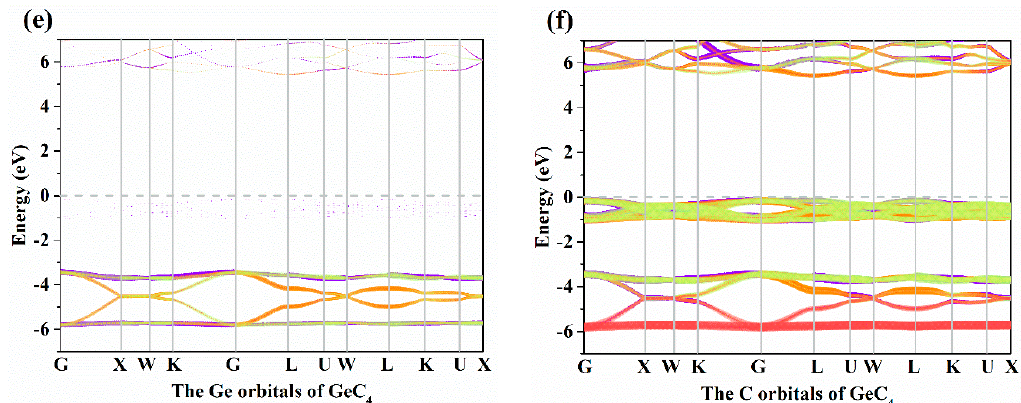
Figure 3. The electronic band structures for ( a ) Si-diamondyne and ( b ) Ge-diamondyne; the electronic band structures for ( c ) Si atom and ( d ) C atom of Si-diamondyne; and the electronic band structures for ( e ) Ge atom and ( f ) C atom of Ge-diamondyne.